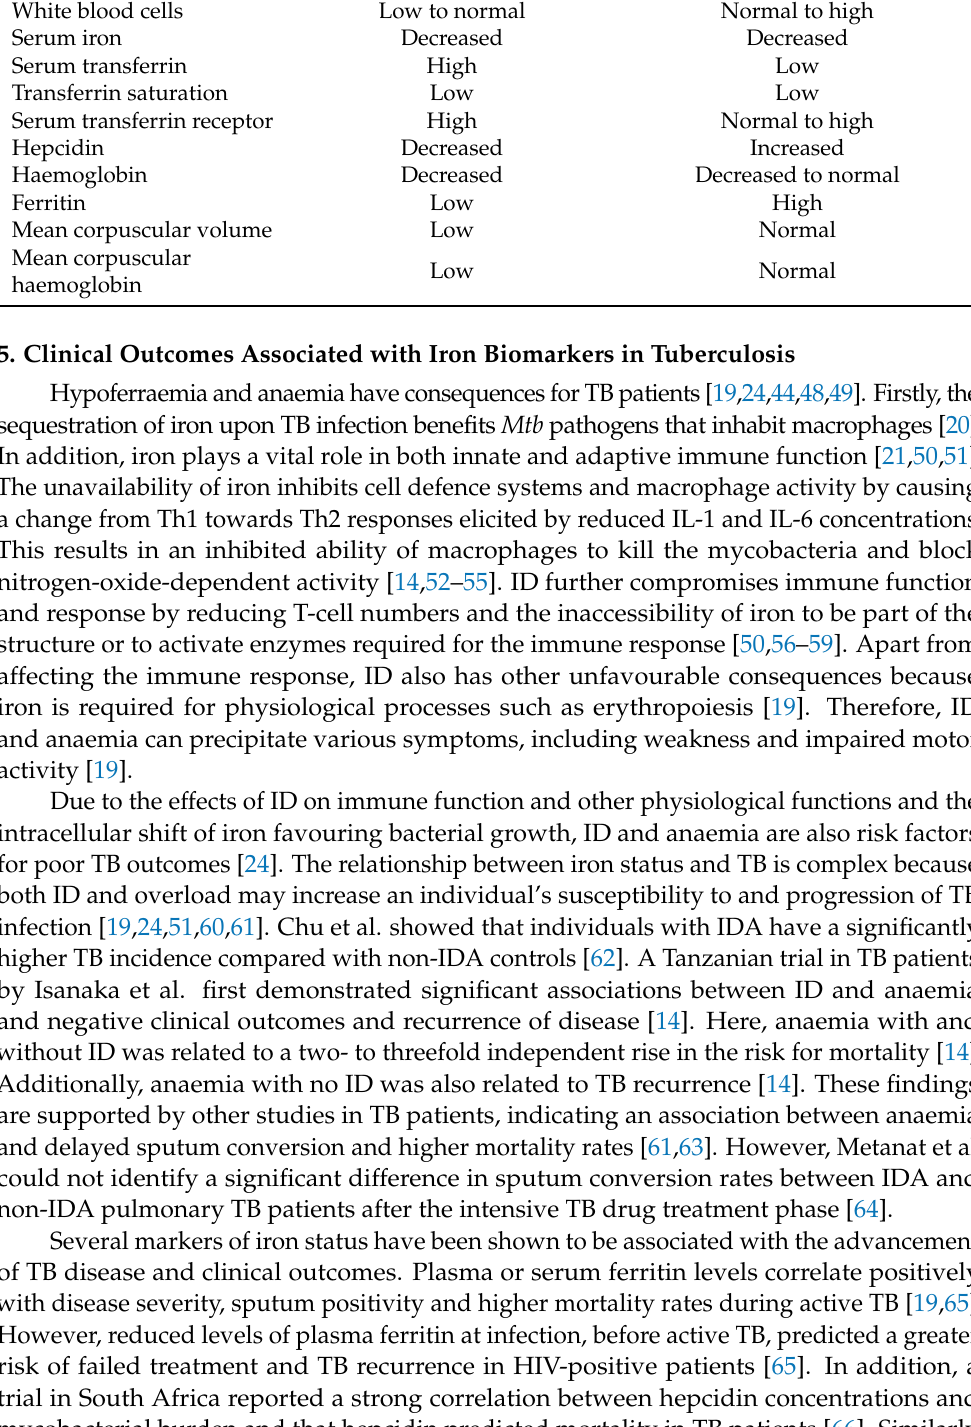
Table 1. Biomarker changes anticipated in anaemia of infection and iron deficiency anaemia. Levels in Iron Levels in Anaemia of Infection Biomarker Deficiency Anaemia Red blood cells Low White blood cells Low to normal Normal to high Serum iron Decreased Decreased Serum transferrin High Transferrin saturation Serum transferrin receptor High Normal to high Hepcidin Decreased Increased Haemoglobin Decreased Decreased to normal Ferritin Low High Mean corpuscular volume Low Normal Mean corpuscular Low haemoglobin